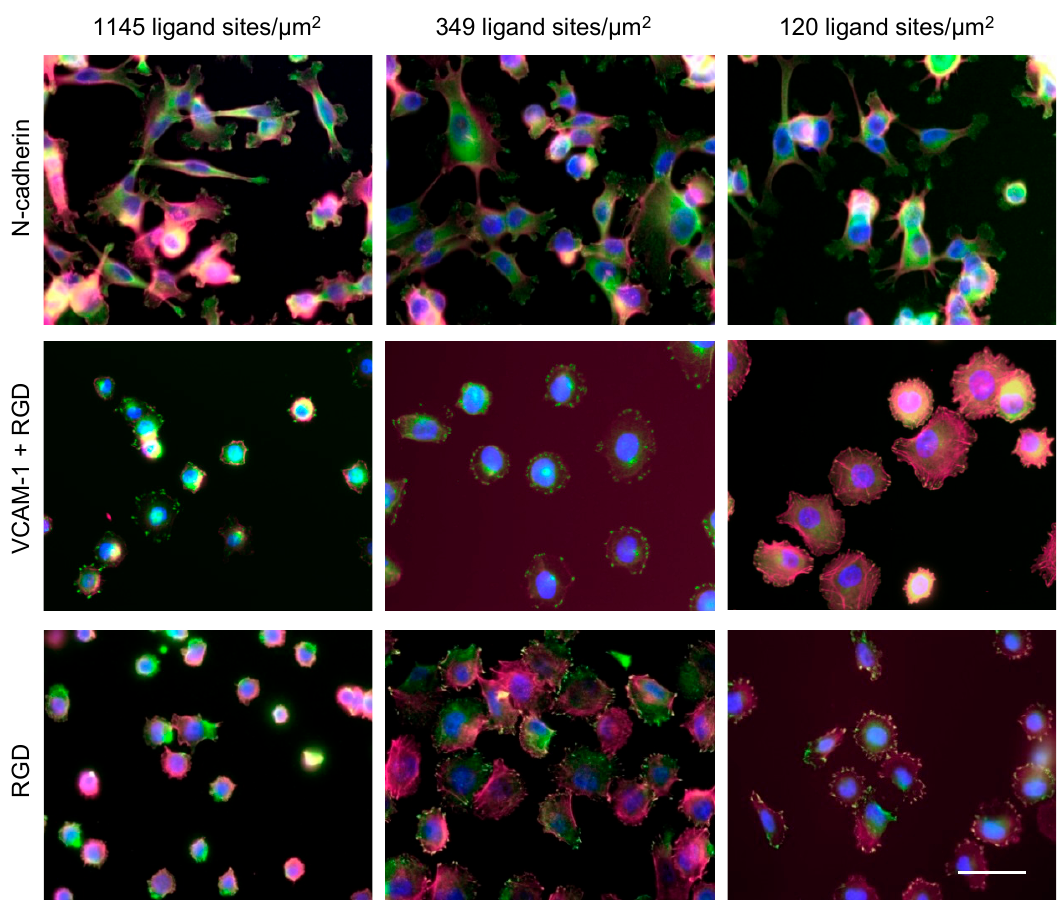
Figure 3. Nanotechnology unravels distinct linear and non-linear effects of extracellular ligands on melanoma cell functions. Human melanoma cells (cell line A375) spread on N-cadherin (upper panel), VCAM-1 (middle panel) and RGD (lower panel) displayed at densities of 1145, 349, and 120 ligand sites/µm 2 (corresponding to lateral distances of 30, 60, and 90 nm), respectively (scale bar = 50 µm). The matrices were produced by identical BCML procedures. The pictures indicate that ligand density and ligand specificity are both relevant in determining the cellular fate: while melanoma cells show similar spreading on different densities of N-cadherin, VCAM-1 exerts an inhibitory effect in a density-dependent linear fashion. Finally, the integrin peptide RGD induces maximum spreading on intermediate densities of RGD peptides. These ligand-specific biophysical traits were revealed by nanotechnology and were not discernable from “conventional” ligand-coating experiments.